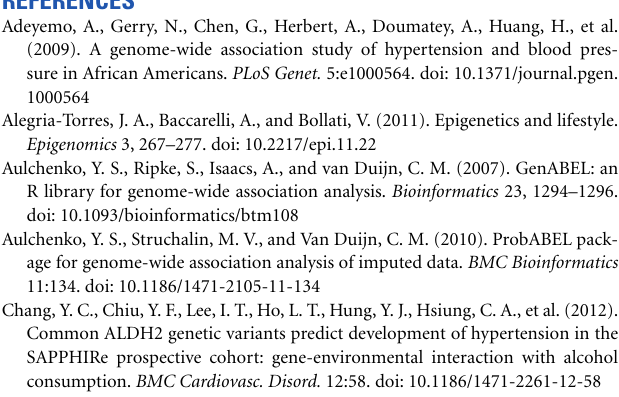
Figure S4 | Quantile-quantile plots of the 1df SNP-alcohol interaction tests for SBP. Plots are presented for all three alcohol measures (drinks per week, days drinking per week, and ounces of alcohol per week) before and after the genomic control adjustment. Figure S5 | Quantile-quantile plots of the 1df SNP-alcohol interaction tests for DBP. Plots are presented for all three alcohol measures (drinks per week, days drinking per week, and ounces of alcohol per week) before and after the genomic control adjustment. Figure S6 | Quantile-quantile plots of the 1df SNP-alcohol interaction tests for MAP. Plots are presented for all three alcohol measures (drinks per week, days drinking per week, and ounces of alcohol per week) before and after the genomic control adjustment. Figure S7 | Quantile-quantile plots of the 1df SNP-alcohol interaction tests for PP. Plots are presented for all three alcohol measures (drinks per week, days drinking per week, and ounces of alcohol per week) before and after the genomic control adjustment. Figures S8–S14 | Regional association plots for loci with suggestive or significant associations by the 1df interaction test or the joint 2df test. Plots are ordered by chromosome and position, with symbol color indicating the strength of the linkage disequilibrium (r-squared value) between the plotted SNP and the index